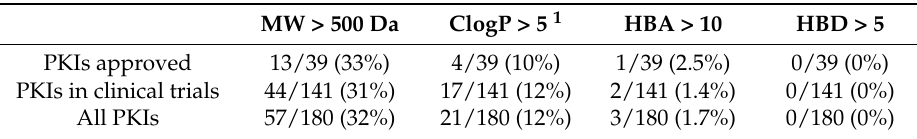
Table A2. Number of PKIs violating at least one Lipinski